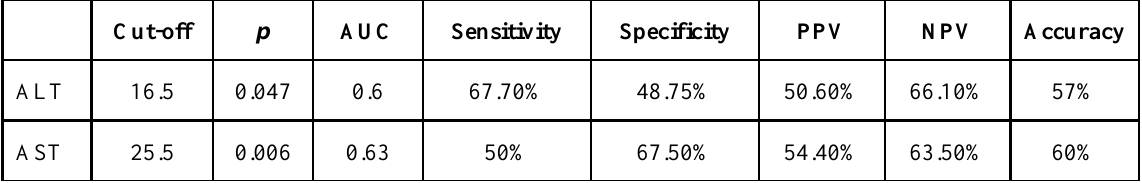
Table 3. The diagnostic performance of the cut-off values of ALT and AST as assessed by ROC curves. Data shown are cut-off level (IU/L), p values, Area Under the receiver operating characteristic Curve (AUC), sensitivity, specificity, positive predictive value (PPV), negative predictive (NPP) and